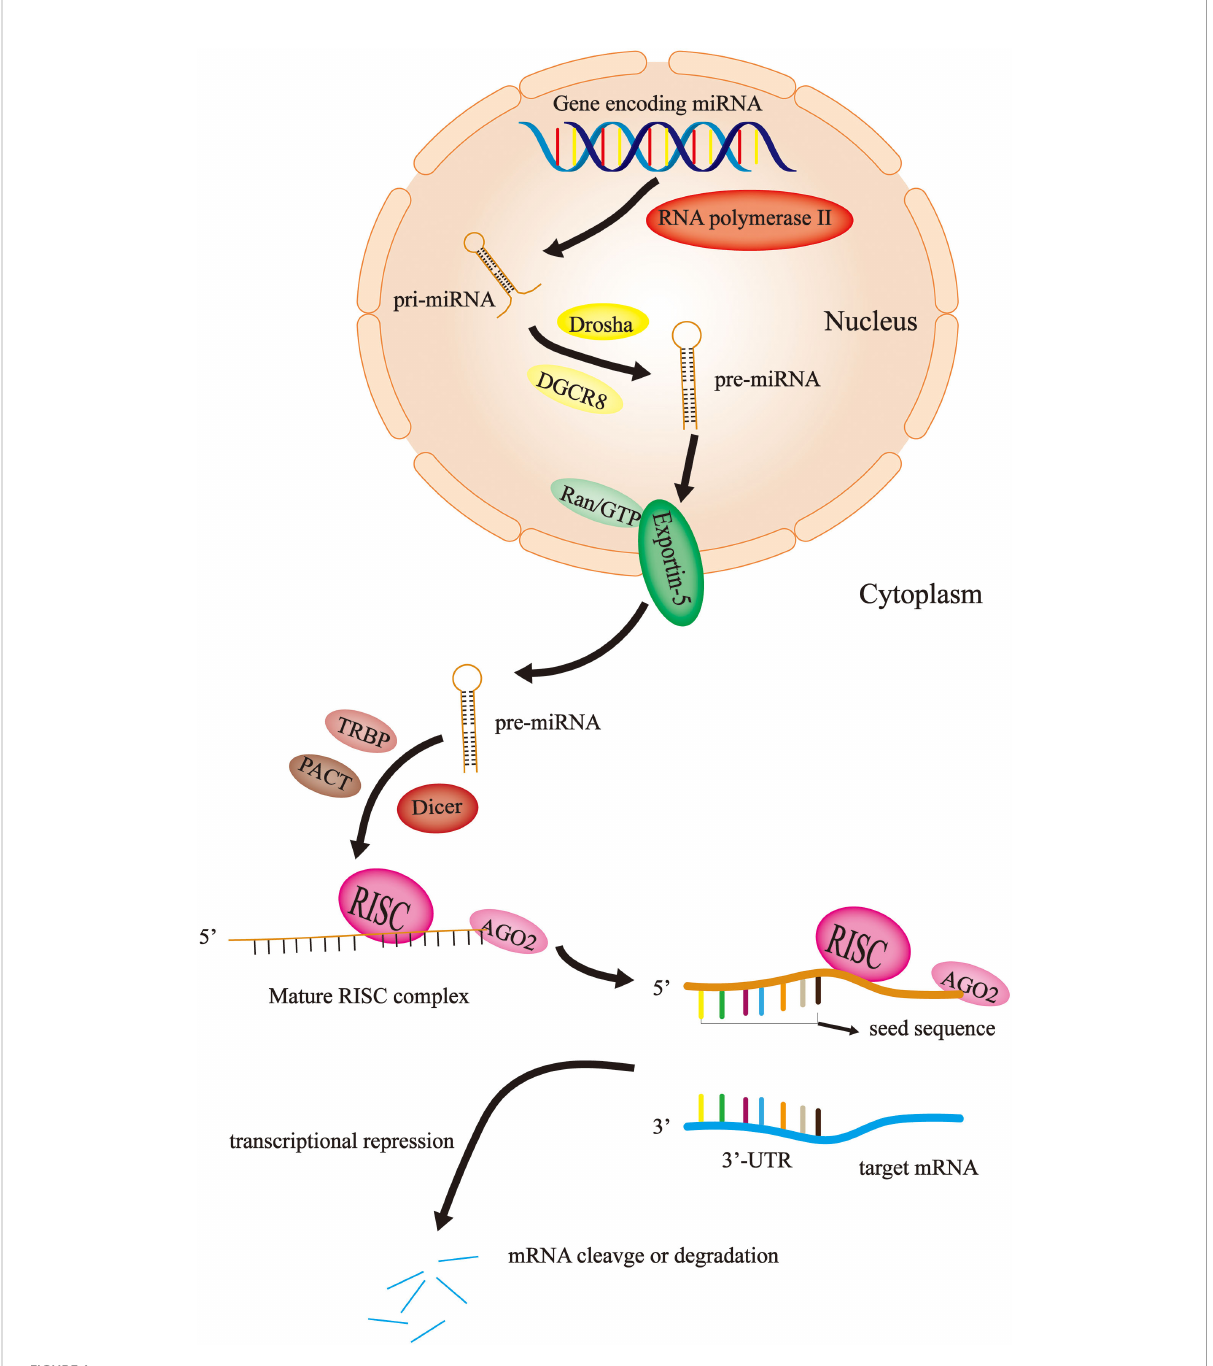
FIGURE 1 miRNA biosynthesis and mechanism of action. In the nucleus, the miRNA gene is transcribed by RNA polymerase II into pri-miRNA, which become pre-miRNA with the help of Drosha and DGCR8. Then, the Ran/GTP/Exportin-5 complex delivers the pre-miRNA to the cytoplasm. Here, with the assistance of Dicer, TRBP and PACT, the pre-miRNA is disassembled into single strands and combined with AGO2 and RISC to become a mature RISC complex. Finally, the RISC complex binds to the target mRNA to cause mRNA degradation or translational